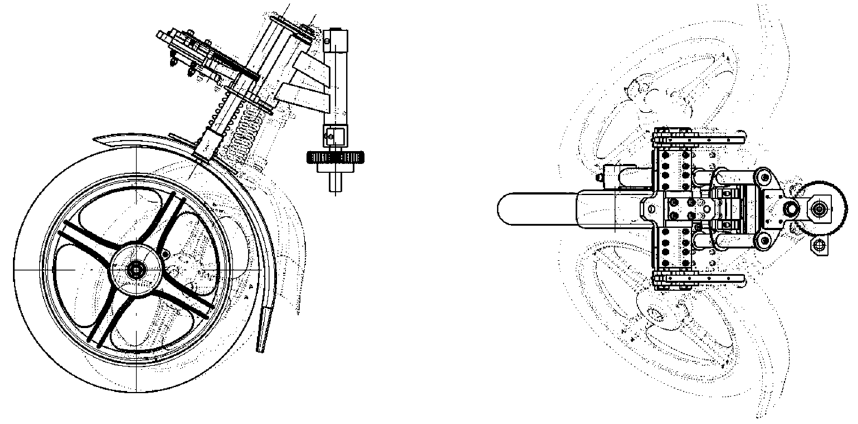
Figure 26. The possibilities of moving the front wheel enabled by a new way of the designed arrangement with the aim of increasing the stability of three-wheeled vehicles during cornering.